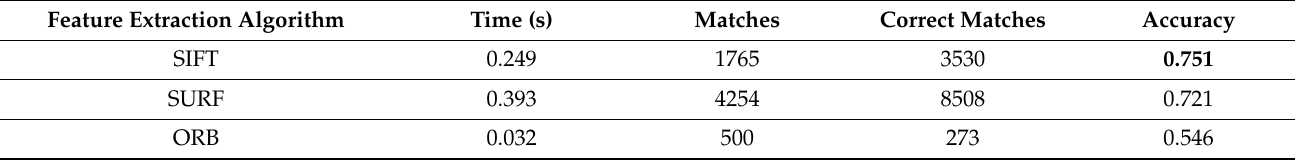
Table 7. Results of comparing the image with its scaled image. The best result is marked in